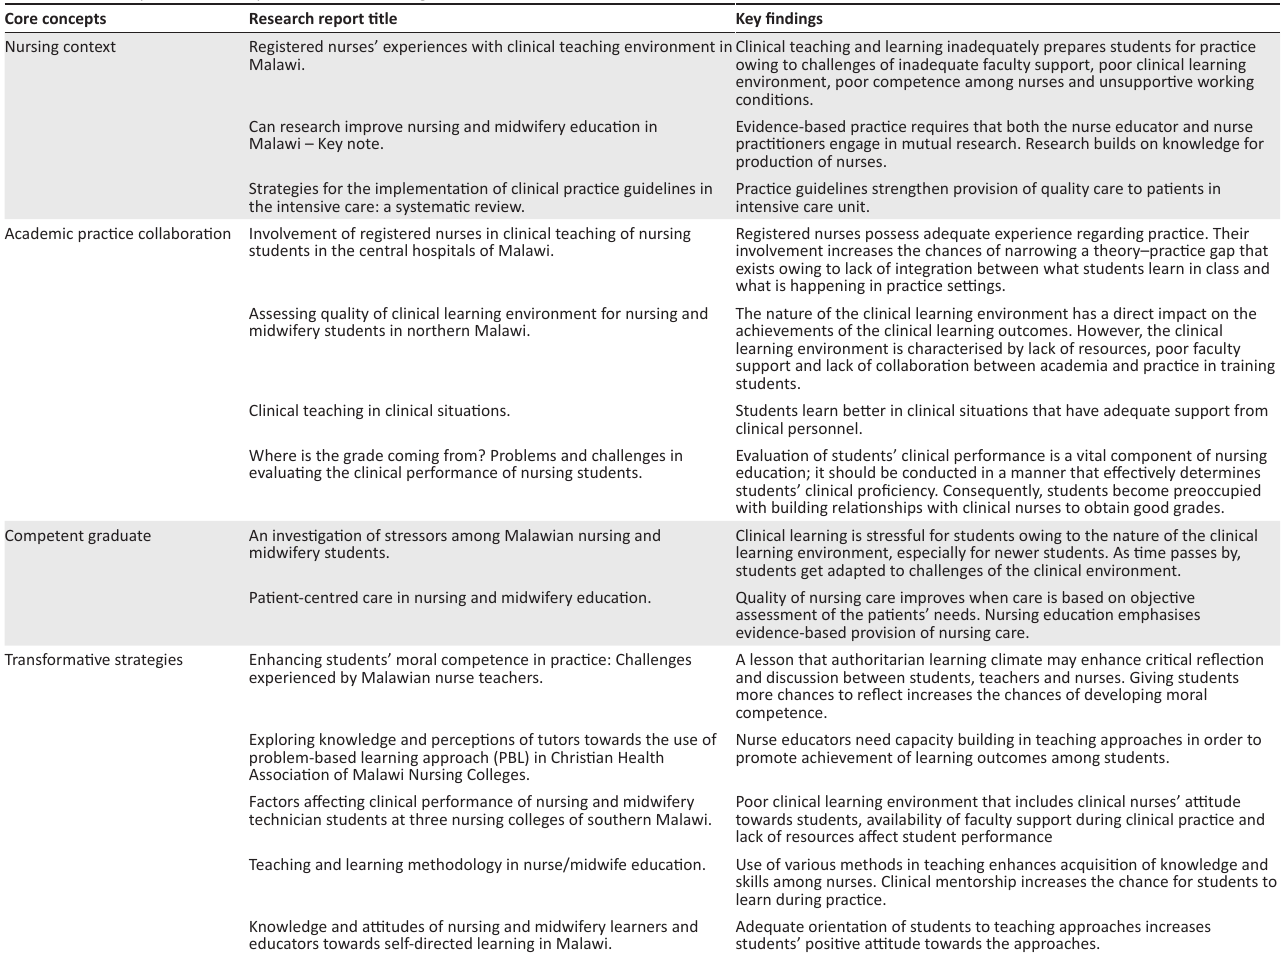
TABLE 1: Summary of research reports from the nursing education research